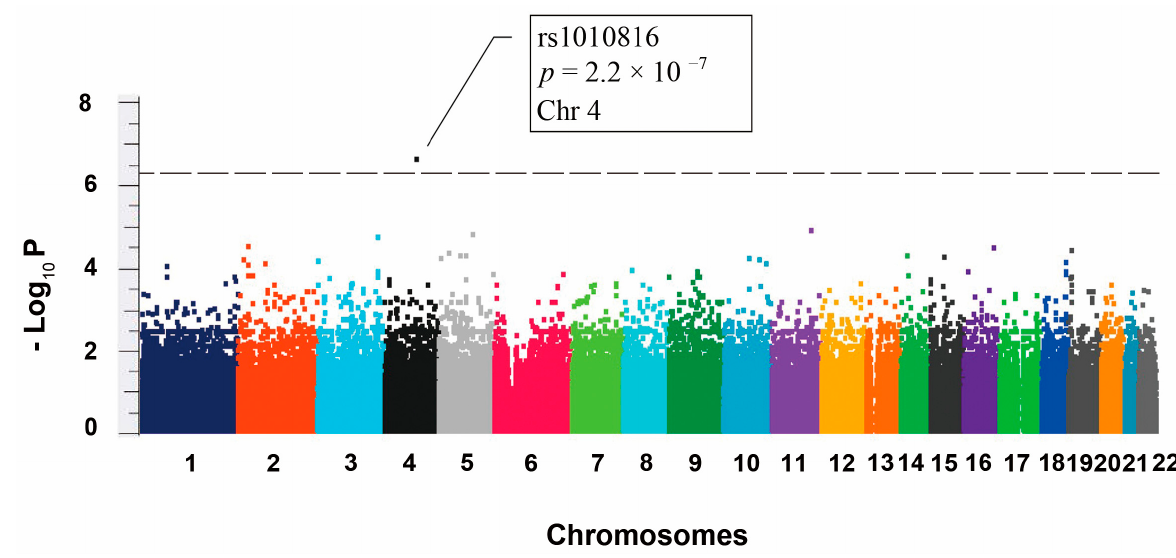
Figure 1. Manhattan plot for sorafenib therapeutic response in advanced HCC patients. The association values in –log 10 p values are shown by chromosome. The chromosomes are shown by different color and labeled with number from 1 to 22. A genome-wide significant association signal is observed and rs1010816 is the top hit. The threshold p value (5 × 10 − 7 ) is displayed as dash line.